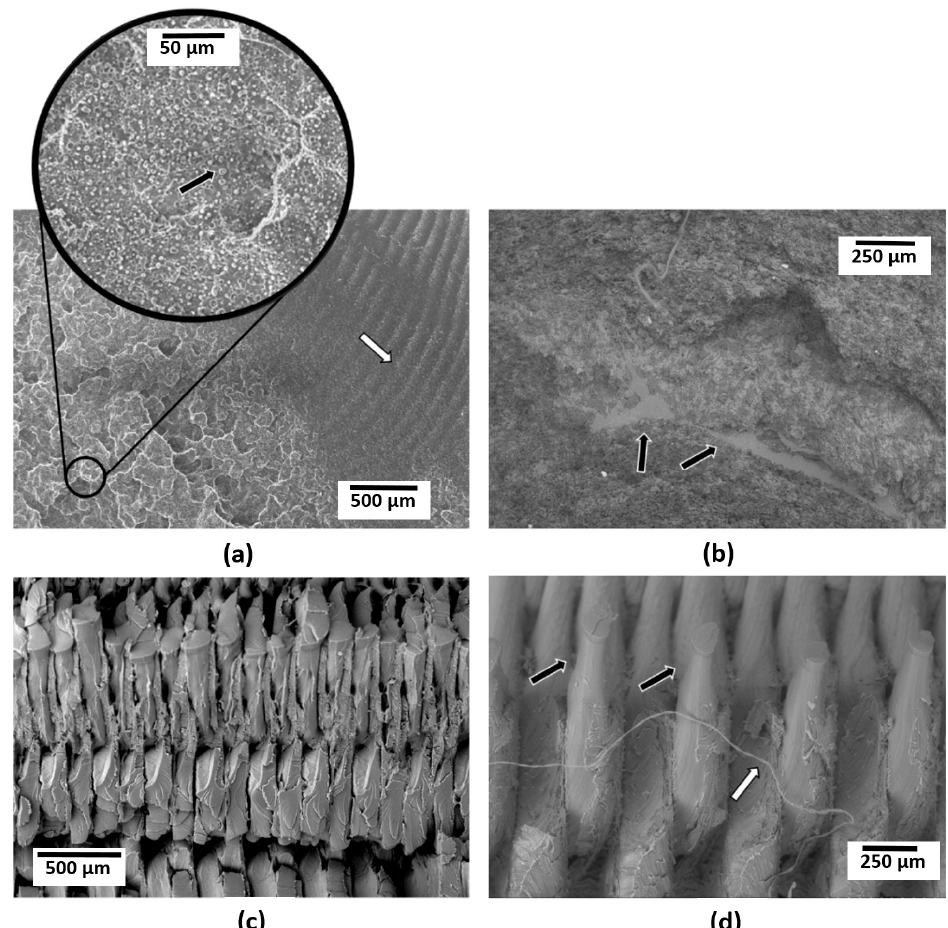
Figure 10. Scanning electron micrographs of the impact test fracture surfaces of ( a ) an injection molded specimen composed of PLA:TPU 50:50, ( b ) an injection molded specimen composed of PLA:SEBS 50:50, ( c ) a FFF-manufactured specimen composed of PLA:TPU 50:50, and ( d ) a FFF-manufactured specimen composed of PLA:SEBS 50:50. Note the differences in fracture surface morphology.